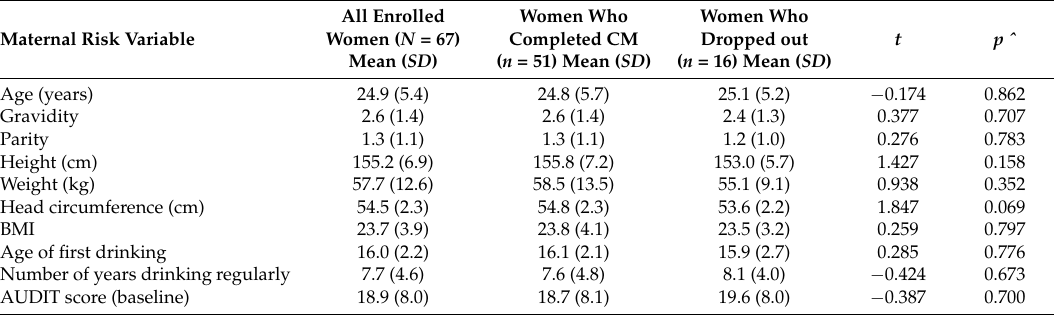
Table 1. Selected physical, childbearing, and alcohol use data at baseline for all women in case management ( N = 67) and comparison of those who completed 18 months of case management ( n = 51) to women who did not ( n = 16).